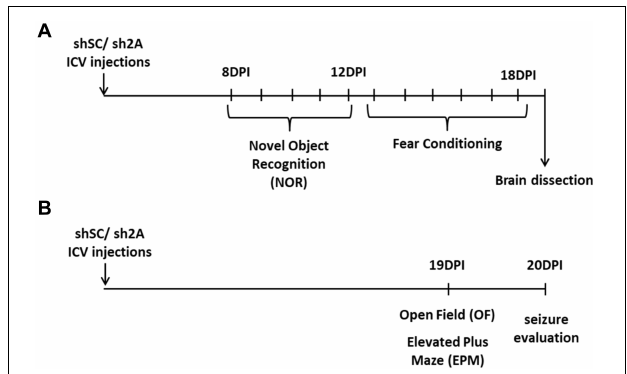
FIGURE 1 | Experimental design. (A) One group of animals was injected bilaterally with AAVe-shsc (control) or AAVe-shGluN2A (shGluN2A) in the hippocampal CA1 region. After 8 DPI, rats were evaluated in novel object recognition (NOR) up to 12 DPI. Then, animals were assayed in contextual fear-conditioning tasks. At 19 DPI, animals were euthanized, and the hippocampi collected to perform mRNA extraction. (B) In a second group of animals, injected either with shsc (control) or shGluN2A AAVe (shGluN2A), anxiety-like behavior was evaluated. At 19 DPI, these rats were exposed to an open field (OF) and then to an elevated plus maze (EPM). At 20 DPI, seizure-induced susceptibility was assessed in these animals by administration of PTZ or saline, as a